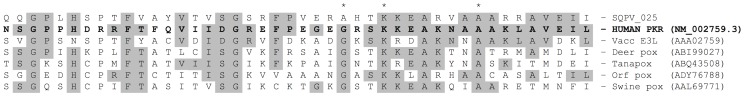
Comparison of the dsRNA interaction domain of SQPV_025, VACV_Cop E3L, human protein kinase R (PKR) and related proteins from other poxviruses.Conserved residues with the human form are indicated by a grey background. Asterisks above the alignment indicate those residues that have been shown to be necessary for dsRNA binding in E3L [7].